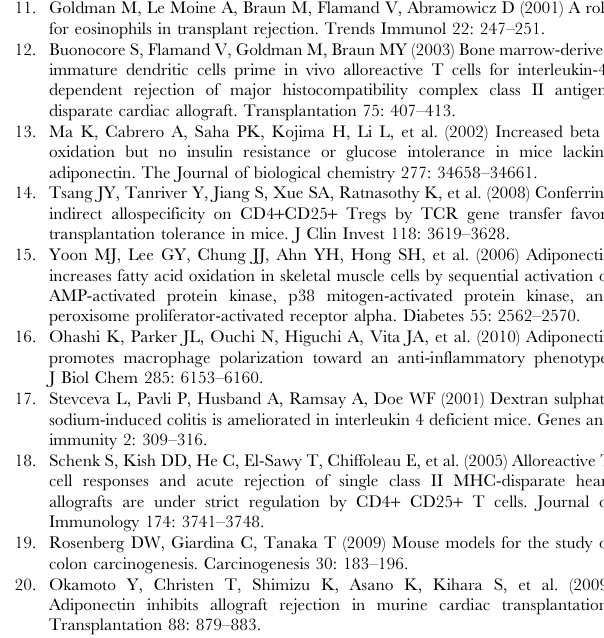
Figure S1 Immunohistochemical analysis of cardiac transplantation grafts. Sections were stained with Hematox- ylin and Eosin (HE), rat anti-mouse CD4 and CD8 antibodies and bm12 to B6 grafts are compared to bm12 to APM 2 / 2 grafts. The samples were obtained from the grafts which the heart beating was stopped. Figure S2 Immunohistochemical analysis of cellular infiltration. The tissue sections were stained with rat anti-mouse F4/80, rat anti-mouse CD4 and CD8 antibodies to illustrate the containing of macrophages, CD4 + and CD8 + cells in skin transplantation with bm12 as the donor to B6 or Apn 2 / 2 as the recipients. Figure S3 Expression the cytokines mRNA in grafts. Th1, Th17, co-stimulatory molecule PD-L1, APN and its receptors in grafts of bm12 as donor and B6 or Apn 2 / 2 as recipient by Q-PCR were analyzed. One sample was used in each B6 and Apn 2 / 2 group. Figure S4 A Determination of serum FBS concentration used in MLRs containing splenocytes. B and C Effect of Compound C and SB203580 treatment on splenocyte apoptosis using Annexin V staining.